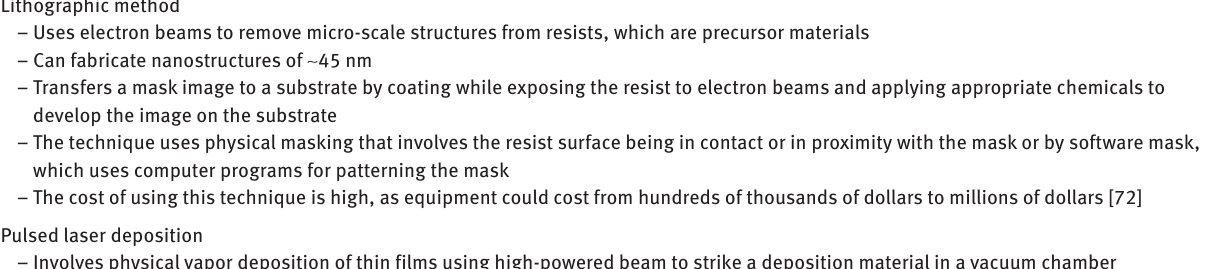
Table 1: Summary of the characteristic of some nanostructure fabrication